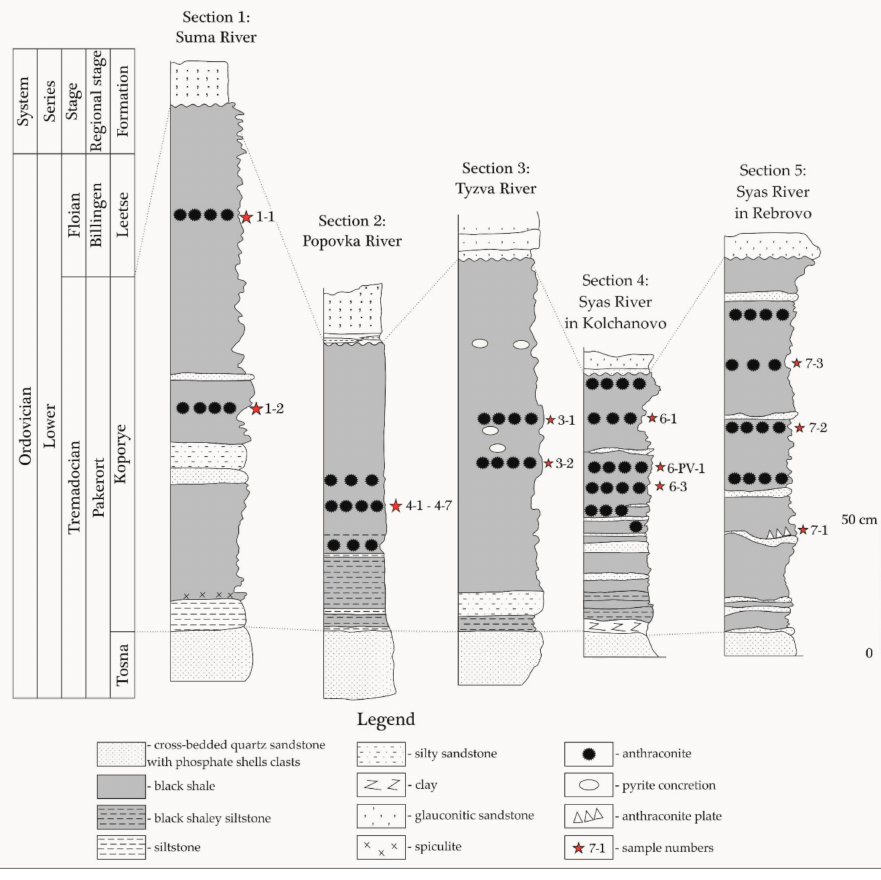
Figure 2. Stratigraphic sections of studied outcrops, with the location of studied